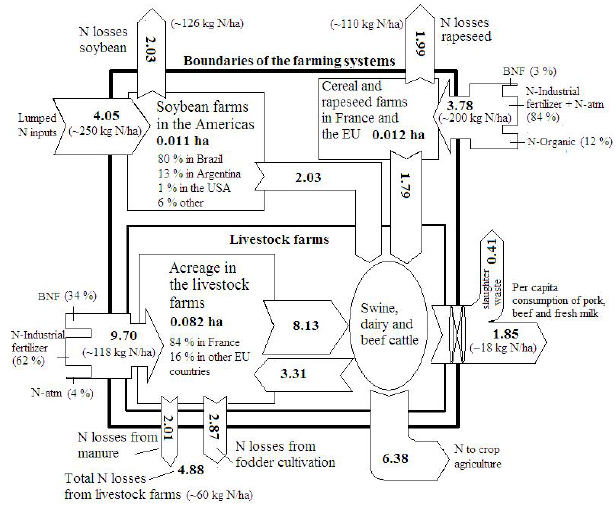
Fig. 9. Nitrogen and land requirements associated with the pro- duction of fresh milk, pork and beef. Arrows refer to per capita N flows (kgNcapyr − 1 ) and rectangles to per capita land requirements (hacap − 1 yr − 1 ) per country of feed production. N input and output per hectare are given in brackets (kgNha − 1